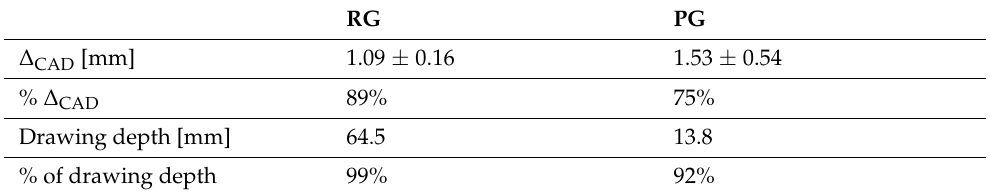
Table 3. Main results of cup LP analysis.